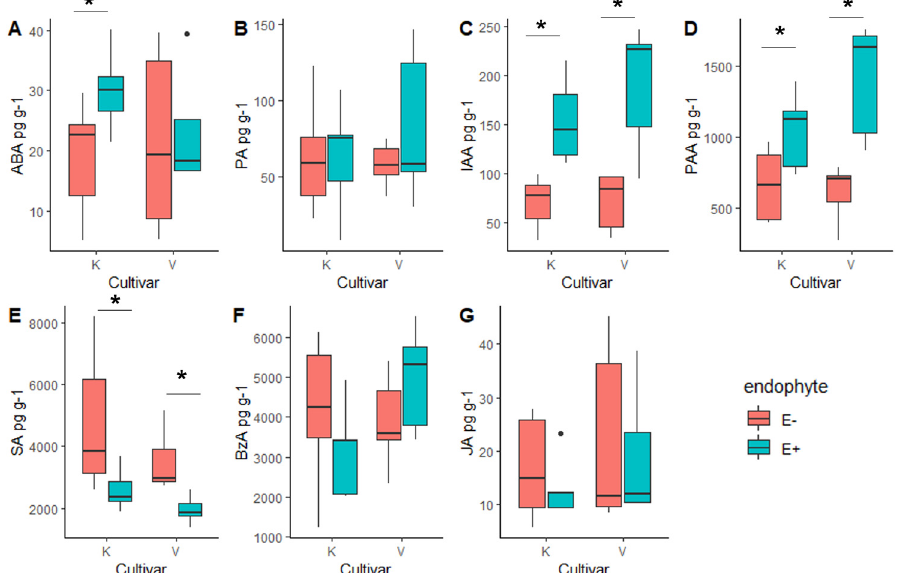
Figure 9. Phytohormone concentrations of meadow fescue ( Festuca pratensis ) cultivars ‘Kasper’ (K) and ‘Valtteri’ (V) were compared between Epichloë -symbiotic (E+) and Epichloë -free (E-) plants (GLM). Median and 95% confidence intervals are shown. The analyses covered the plant hormones ( A ): abscisic acid (ABA), ( B ): the main product in ABA metabolism phaseic acid (PA), ( C ): indole acetic acid (IAA), ( D ): phenyl acetic acid (PAA), ( E ): salicylic acid (SA), ( F ); a potential SA precursor benzoic acid (BzA) and ( G ): jasmonic acid (JA). Dots show outliers beyond 1.5-times the interquartile range, which is represented by whiskers; * = p < 0.05.